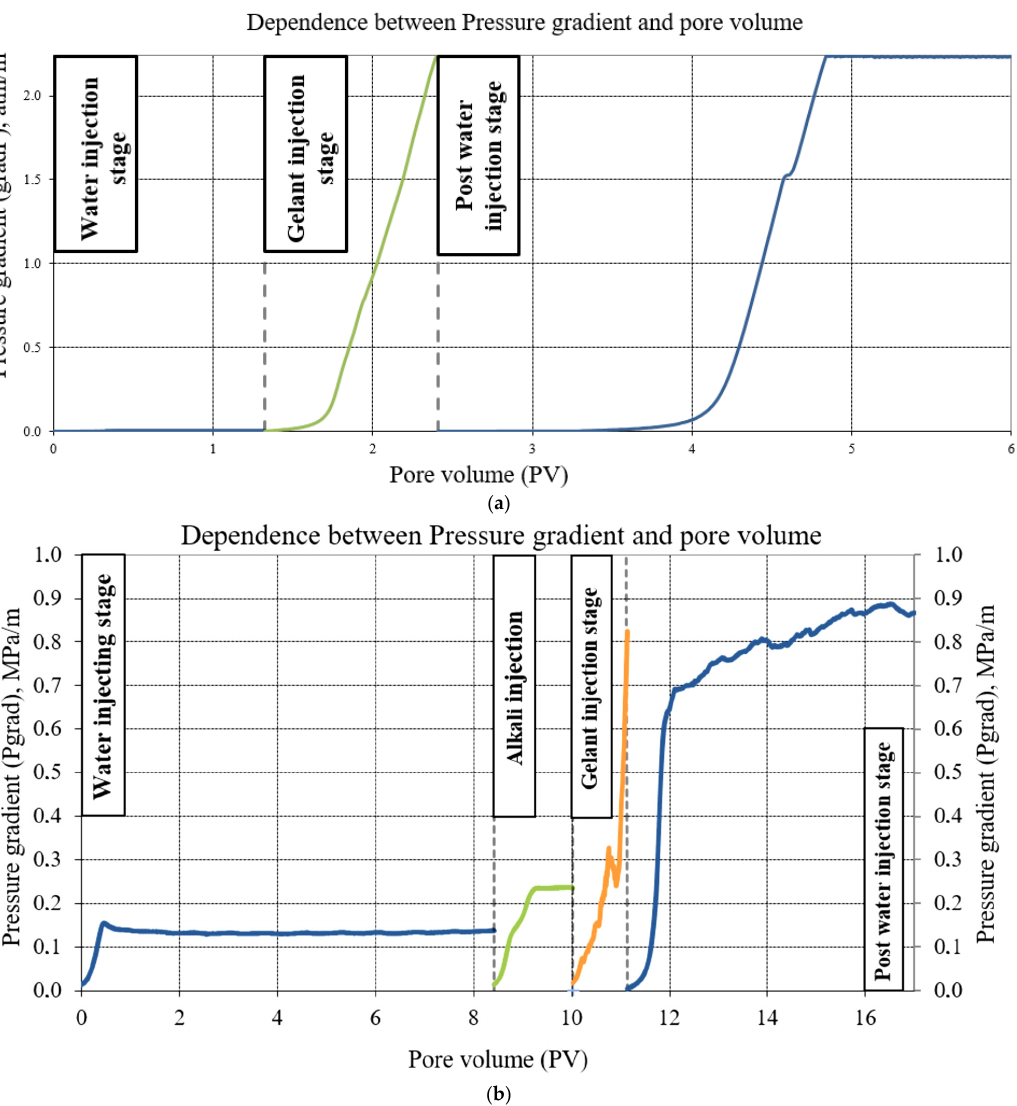
Figure 8. Injection curve during the experiment for the initial composition ( a ) and the proposed one ( b ). During the polymer composition injection into the heterogeneous reservoir model, the oil was displaced from the high-permeable as well as the low-permeable core samples, which exemplifies the penetration of the gelant into both cores, due to its high viscosity. This was demonstrated during the gelant injection stage. The pressure gradient increased steadily during the gelant injection.